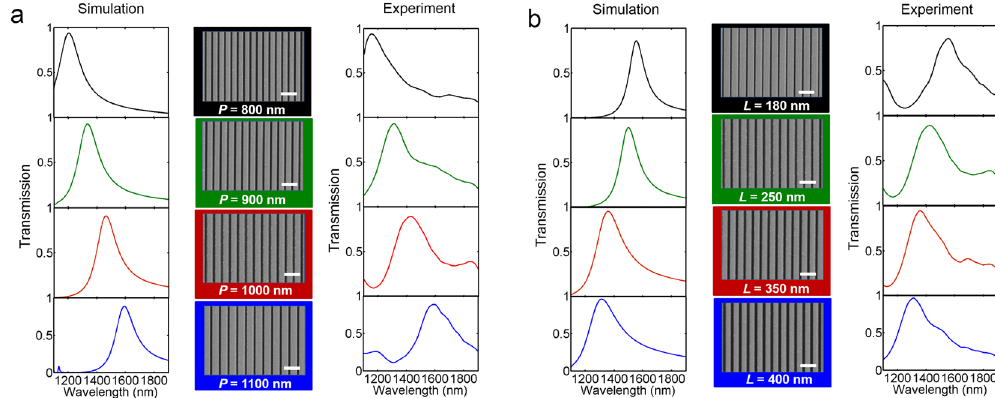
Figure 2. Calculated and measured transmission spectra for various periodicity P and slit width L . ( a ) Periodicity P from top to bottom are 800, 900, 1000, 1100 nm. ( b ) Slit width L from top to bottom are 180, 250, 350, 400 nm. In Fig. 2(a) and (b), left column is calculated from FDTD simulations, and right column is from experiment. Central column shows the corresponding SEM images. Scale bar, 2 μ